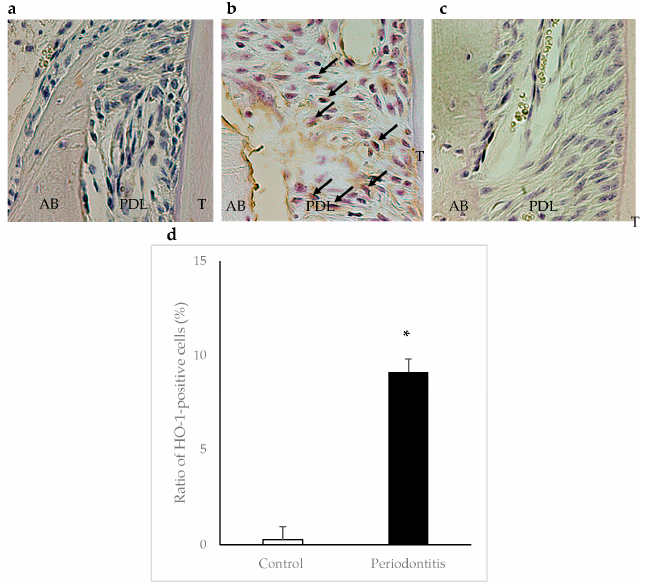
Figure 5. Immunohistochemical staining of heme oxygenase-1 (HO-1) in periodontal tissue at day 7. Arrows show HO-1-positive cells. A higher number of HO-1-positive cells was observed in areas adjacent to the alveolar bone surface within the periodontal ligament in the periodontitis group ( b ) than in the control group ( a ) (×400). Panel ( c ) shows a negative control. The ratio of HO-1-positive cells was significantly higher in the periodontitis group than in the control group (* p < 0.05, t -test) ( n = 6/group) ( d ). AB, alveolar bone; PDL, periodontal ligament; T, tooth.